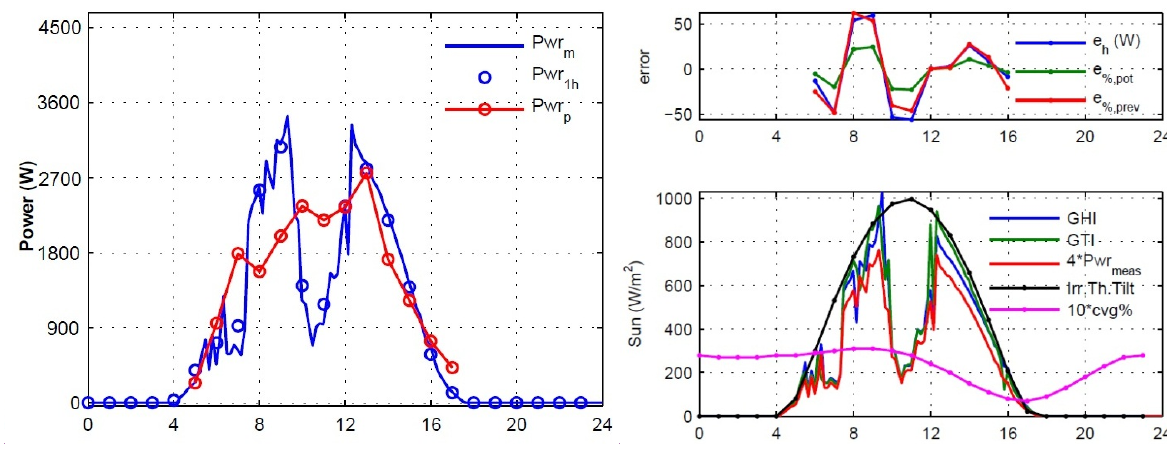
Figure 4. Daily detail of the curves of radiation (theoretical, forecast and actual) with the calculation of the error values during day with bad weather conditions.